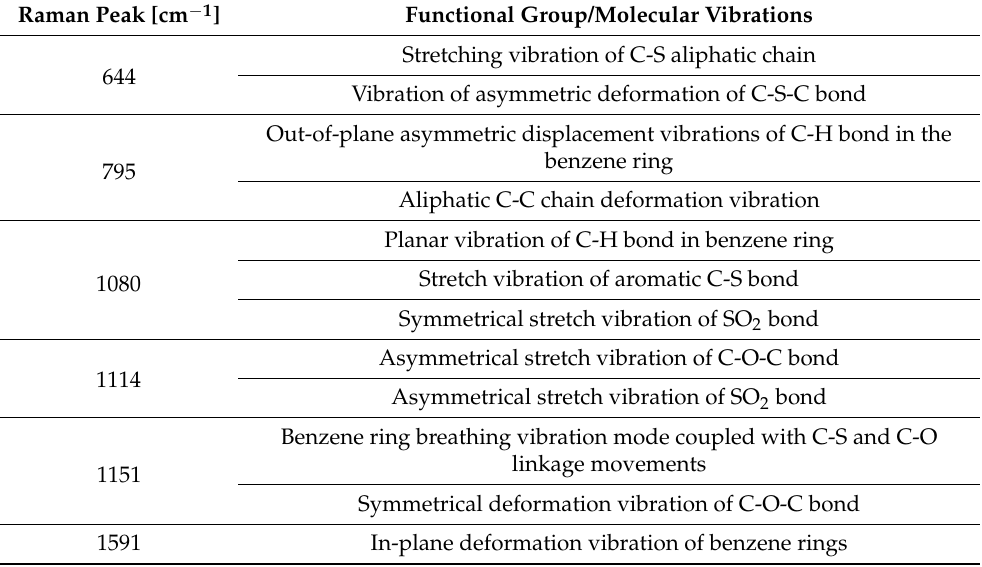
Table 3. Assignment of polysulfone characteristic Raman peaks with possible functional groups or specific molecular vibrations, collected from the literature